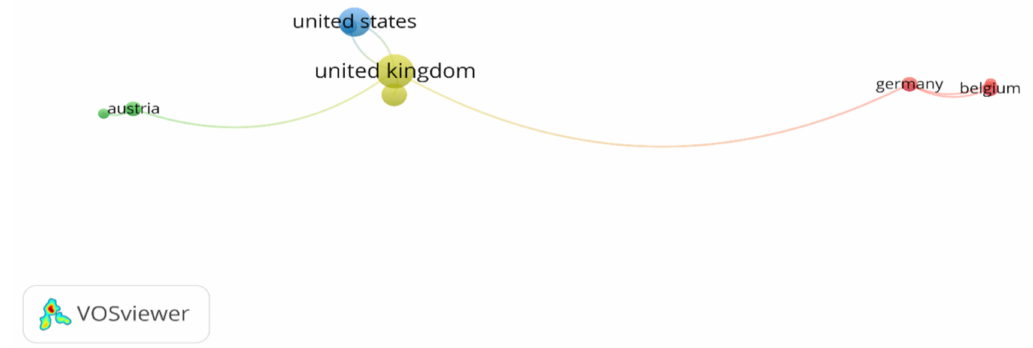
Figure 12. Network of cooperation based on co-authorship between countries in the Mathematics area. Source: own elaboration. Four different groups have been observed. The red group includes Belgium, Germany, and Luxembourg. The countries associated with the green colour are Austria and